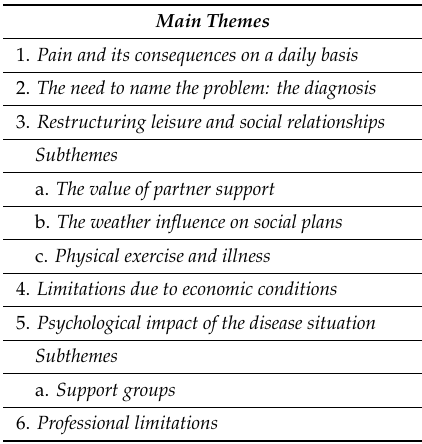
Table 3. Themes and